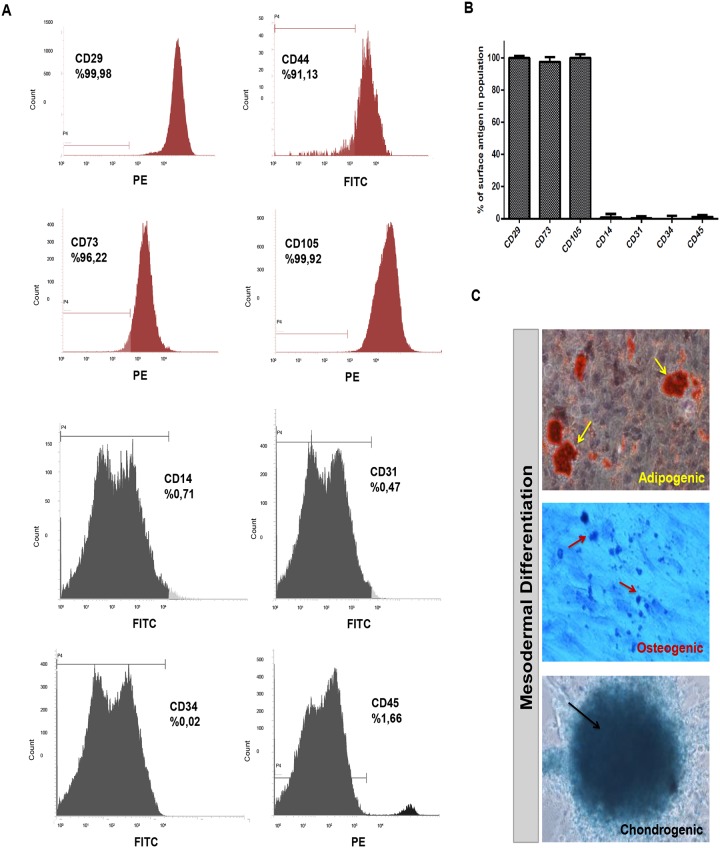
Isolated cells from bone marrow stroma of healthy donors display typical hMSC phenotype and mesodermal differentiation capacity (A, B) After isolation of human bone marrow cells from healthy donors, cells at passage 3 were analyzed by flow cytometry for phenotypic characterization. The cells showed hMSC specific marker expressions with negative expression of CD14, CD31, CD34, and CD45, while they were positive for CD29, CD44, CD73 and CD105. Representative histograms and surface antigen profiles of isolated adherent cells from 5 healthy donors are demonstrated. (C) Adipogenic differentiation was confirmed by Oil Red-O staining of lipid vacuoles (with hematoxylin counterstain); osteogenic differentiation was followed with Toluidine Blue staining of calcium deposits showing mineralization; and Alcian Blue staining of proteoglycans in chondrogenic pellet demonstrated chondrogenic differentiation.